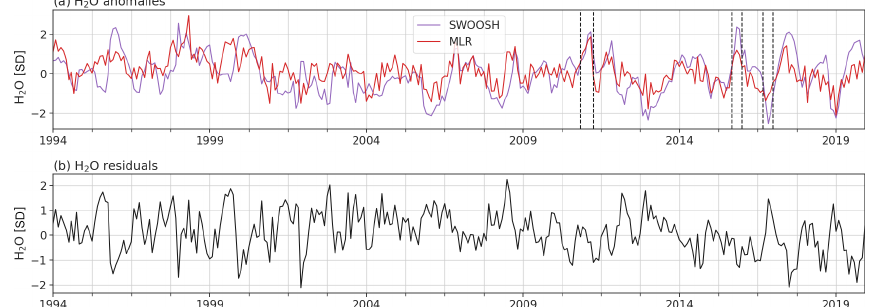
Figure 9. (a) Deseasonalized and standardized water vapor at 82.54hPa averaged between 15 ◦ S and 15 ◦ N (purple) and their MLR recon- struction (red) and residuals, spanning from 1994 to 2019. This MLR analysis was carried out with the Randel and Park (2019) CPT as the only predictor but after detrending the data. The MLR model was trained on the MLS portion of SWOOSH (2005 to 2019; correlation = 0.68) and was reconstructed on the full time span (1994–2019; correlation = 0.59). (b) The residuals from the MLR